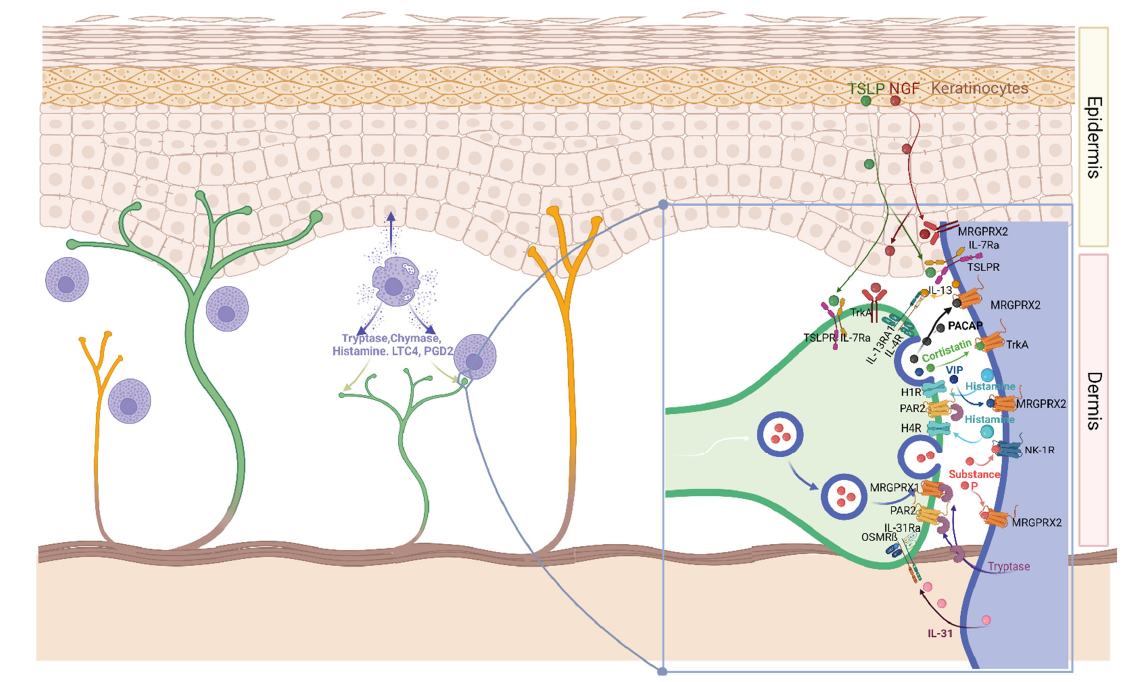
Figure 1. MCs communicate with sensory nerves in the skin. MCs are frequently situated near neurons, whereby the two are engaged in a close dialogue. Neuropeptides such as SP and cortistatin degranulate MCs, chiefly by activating on MRGPRX2; NK-1R can be contributory in the case of SP. Mediators exocytosed from MCs comprise the pruritogens histamine and tryptase, which act on H1R, H4R, and PAR2 on nerve endings (and potentially Mrgprs, i.e., MRGPRX1) on sensory neurons. In addition, the MC-derived cytokines IL-13 and IL-31 can further prime sensory neurons and induce their growth and sprouting. In the skin, keratinocytes occupy an important role and strongly influence both neurons and MCs, e.g., by provision of NGF and TSLP. See text for further details. For the sake of simplicity, the communication is depicted for one nerve only; however, in reality, different receptor combinations characterize subsets of sensory neurons, whereby distinct entities exclude others. Abbreviations: H1R (Histamine H1 receptor), H4R (Histamine H4 receptor), IL-13 (Interleukin-13), IL-13RA1 (Interleukin-13 receptor alpha 1), IL-31R (Interleukin-31 receptor), IL-7Ra (Interleukin 7 receptor alpha), LTC4 (Leukotriene C4), MRGPRX1 (Mas-related G-protein- coupled receptor member X1), MRGPRX2 (Mas-related G-protein-coupled receptor member X2), NGF (Beta-nerve growth factor), NK-1R (Neurokinin receptor-1), OSMRß (Oncostatin-M-specific receptor subunit beta), PACAP (Pituitary adenylyl cyclase-activating protein), PAR2 (Proteinase- activated receptor 2), PGD2 (Prostaglandin D2), TrkA (Tyrosine kinase receptor A), TSLP (Thymic stromal lymphopoietin), TSLPR (Thymic stromal lymphopoietin receptor), and VIP (Vasoactive intestinal peptide).